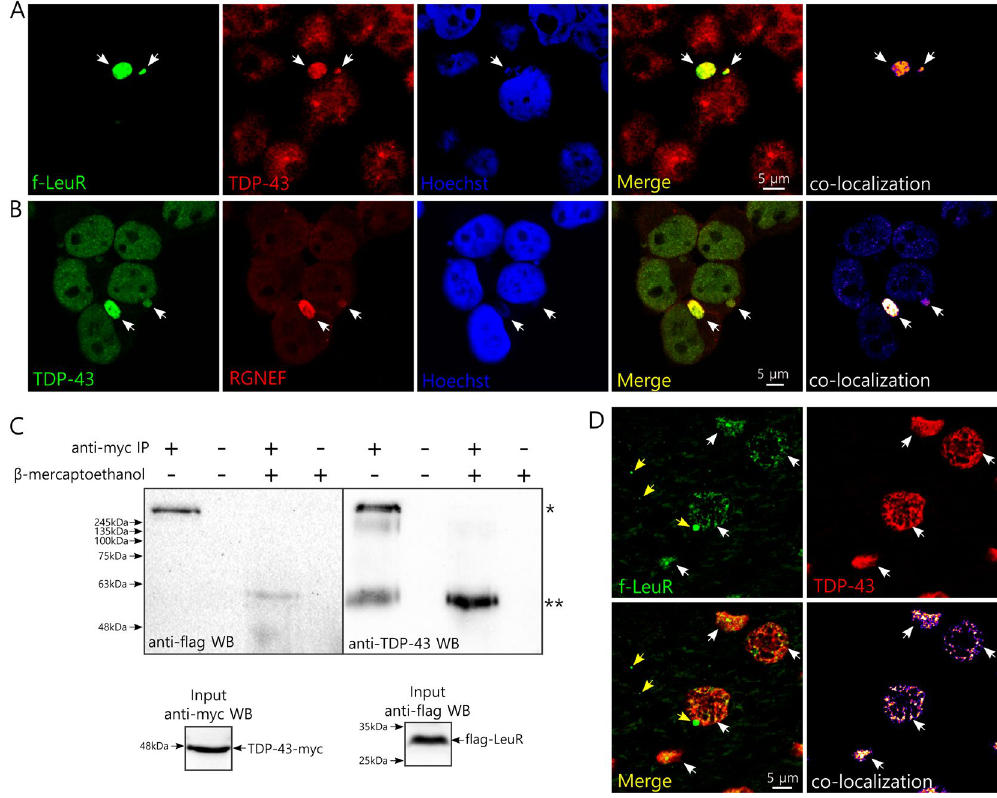
Figure 3. TDP-43 co-localizes with f-LeuR and endogenous RGNEF within micronuclei and interacts in vitro and co-localizes in vivo with f-LeuR. ( A , B ) Representative confocal images of HEK293T cells showing co-localization (white arrows) of endogenous TDP-43 with f-LeuR (A) or endogenous RGNEF (B) within micronuclei after cellular metabolic stress using lactate. ( C ) IP of TDP-43-myc after crosslinking using DTSSP on protein lysate from HEK293T cells expressing f-LeuR and TDP-43-myc. WB was performed for detecting flag and then TDP-43 after stripping. Input controls are showed. β -mercaptoethanol was used to dissociate the crosslinked complex ( * and ** mark electrophoretic shifts of approx. 440 kDa and 60 kDa, respectively). ( D ) Schematic of scAAV-9-LeuR virus and representative confocal images showing the extensive co-localization (white arrows) between LeuR and TDP-43 in brain of rats 4 weeks after the injection with the virus that express flag-LeuR in neurons under SYN1 promoter (yellow arrows indicate granular L-rich that doesn’t co-localize with TDP-43). The proteins were detected using goat anti-flag and rabbit anti-TDP-43